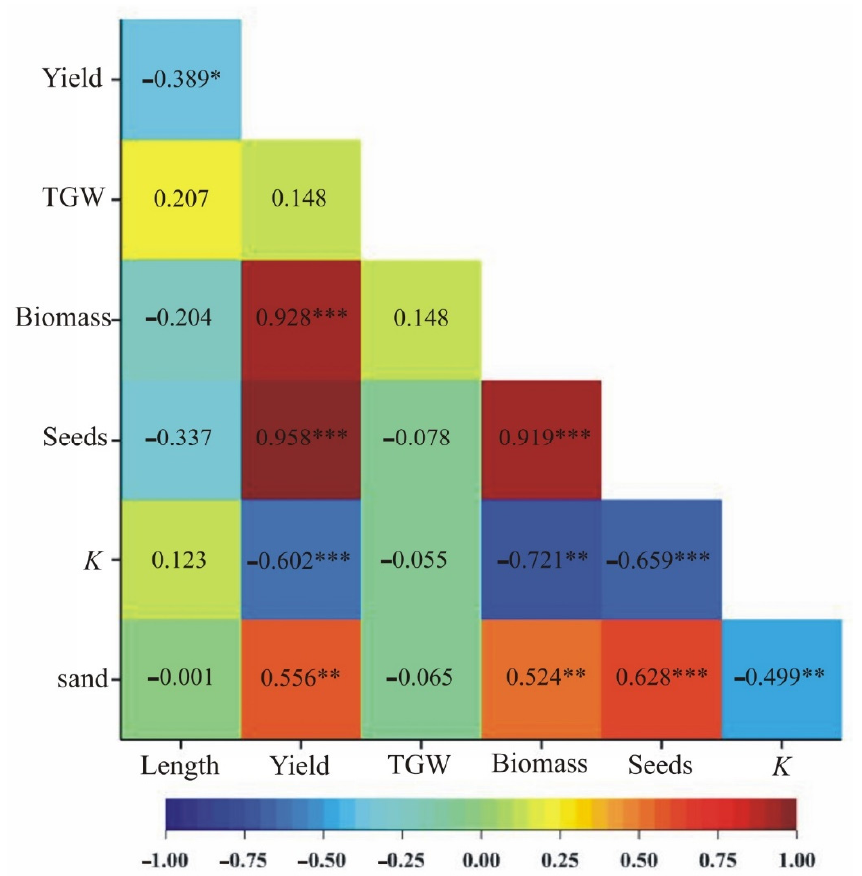
Figure 10. Heatmaps matrix for relationships between observed traits constructed on the basis of linear Pearson’s correlation coefficients, in season 2018–2019. *, **, ***— significant at level 0.05, 0.01, 0.001, respectively.